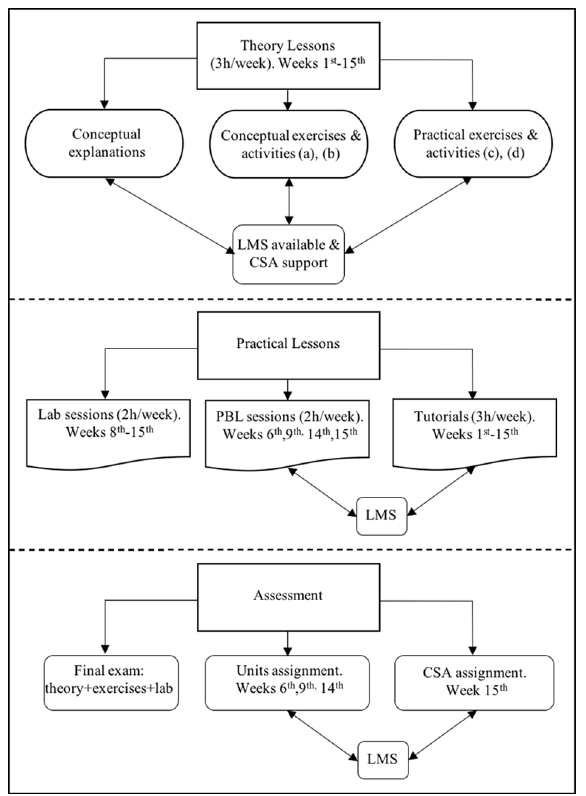
Figure 1. Synthetic diagram for the learning